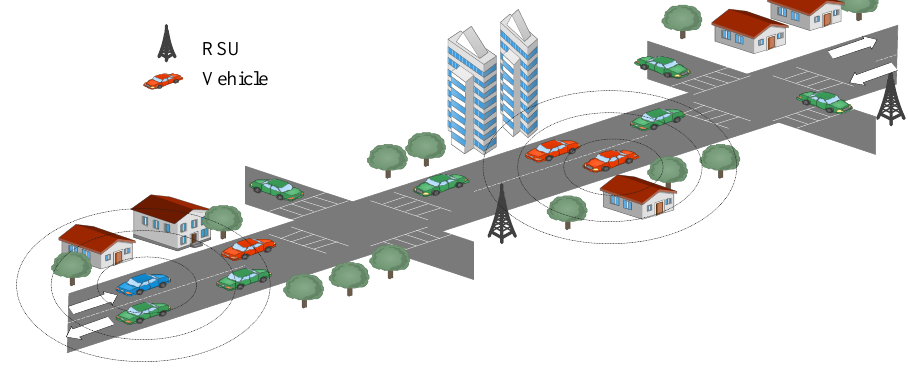
Figure 1. A highways traffic Environment.